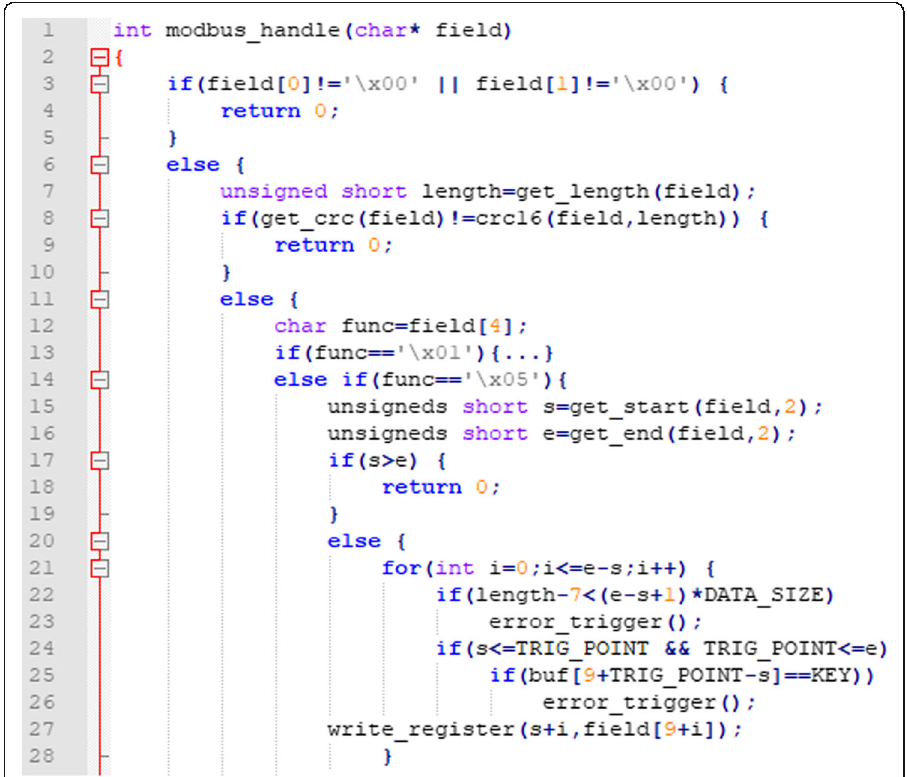
Fig. 6 An example of industrial Internet protocol code